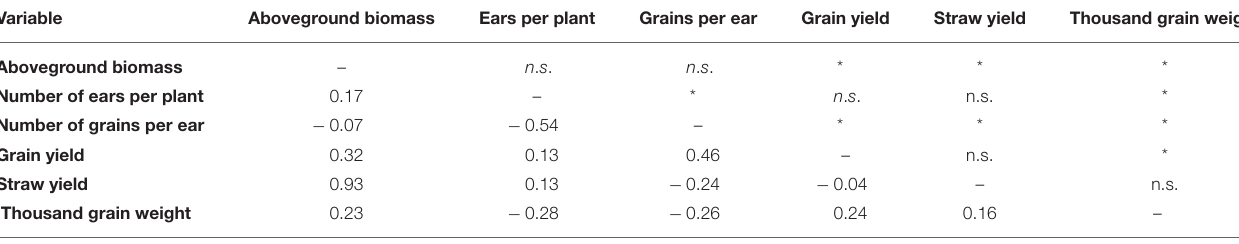
TABLE 3 | Phenotypic correlation coefficient, (phenotypic correlation coefficient, Pearson) between traits across environments. Variable Aboveground biomass Aboveground biomass